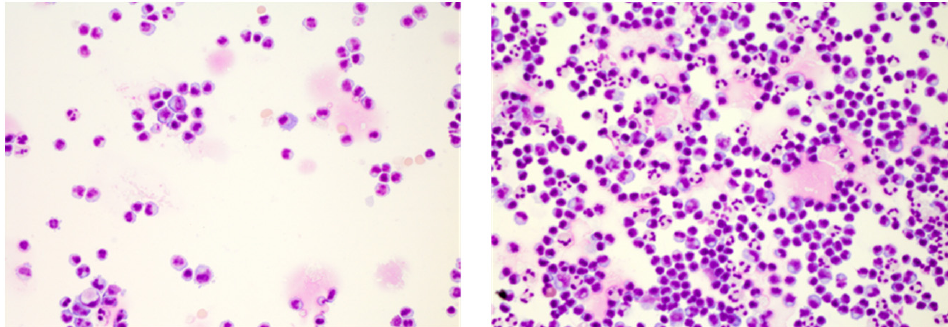
Figure 1. Cerebrospinal fluid (CSF cytology illustrating the impact of elapsed time on CSF cells. Shown are May–Grünwald stained CSF cells of an enterovirus meningitis case featuring an activated lymphocytic phenotype and 152 cells/ µ L after several hours of delayed processing ( left ) and a predominant lympho-monocytic activated phenotype with intermingled granulocytes and 299 cell/ µ L upon immediate processing ( right ). Cytology specimen kindly provided by the Department of Laboratory Medicine, Uniklinikum Salzburg, Paracelsus Medical University Salzburg (Chair: Univ- Prof Dr. Elisabeth